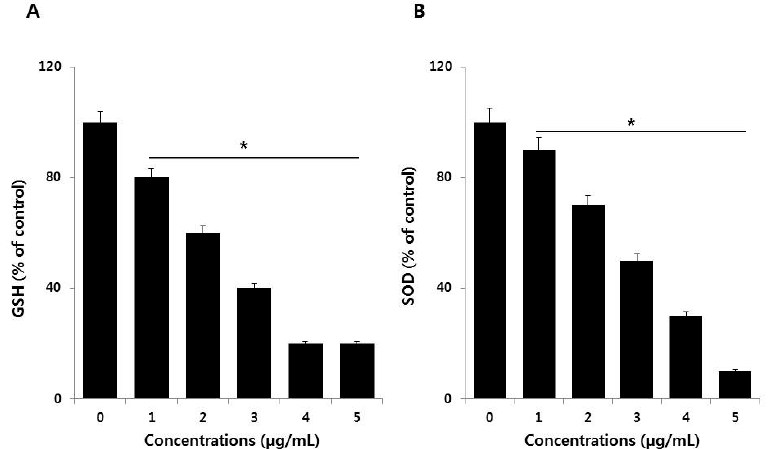
Figure 5. Measurement of antioxidant levels in SKOV3 cells. ( A ) The concentration of glutathione (GSH) is expressed as milligrams per gram of protein. ( B ) The specific activity of superoxide dismutase (SOD) is expressed as units per milligram of protein. Treated cells showed statistically significant differences compared to untreated cells, as determined by the Student’s t -test (* p < 0.05).